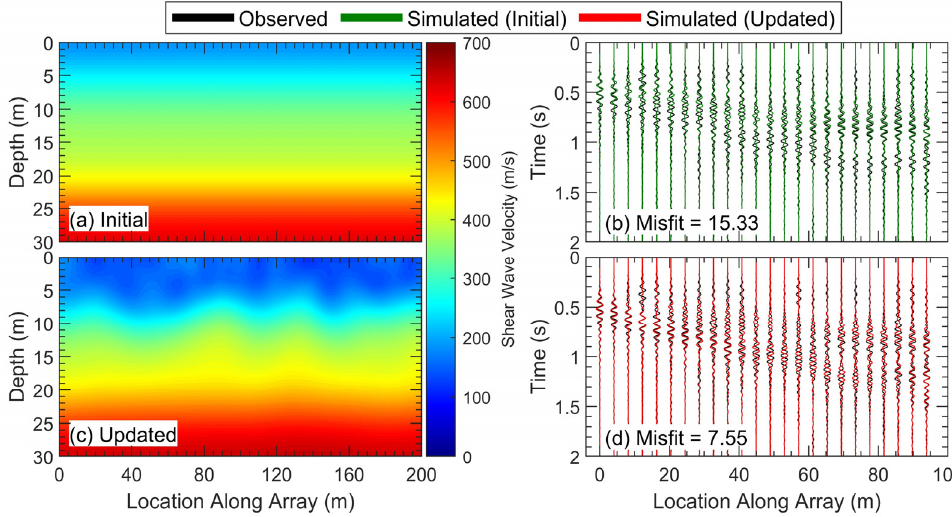
Figure 7. The ( a ) starting and ( c ) updated 2D V S images at the end of FWI Stage 1 (10 to 15 Hz) for the inversion of the MASW starting model. Normalized observed and simulated waveforms from Shot 1 ( − 24 m) for the ( b ) starting and ( d ) updated models at the end of FWI Stage 1 (10 to 15 Hz). GSOTD misfit values for the simulated waveforms from the initial and updated models are shown in the bottom left of plots b and d. Note that for clarity purposes, the waveforms are only shown for every channel used for FWI.